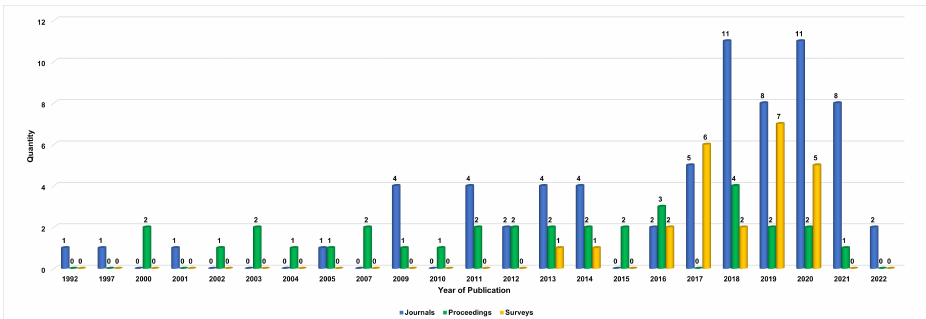
Figure 18. Year of publication for the reviewed literature, of which 67 (53%) are journals, 33 (26%) are proceedings, and 24 (19%) are